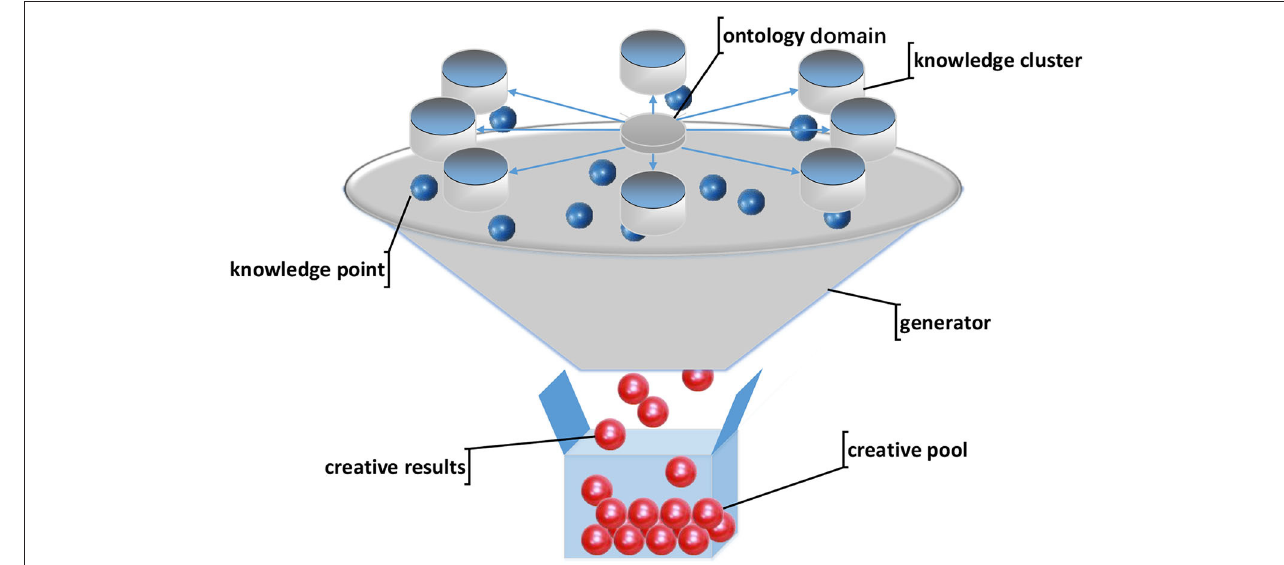
FIGURE 6 | The structure of the probability branch model in the knowledge